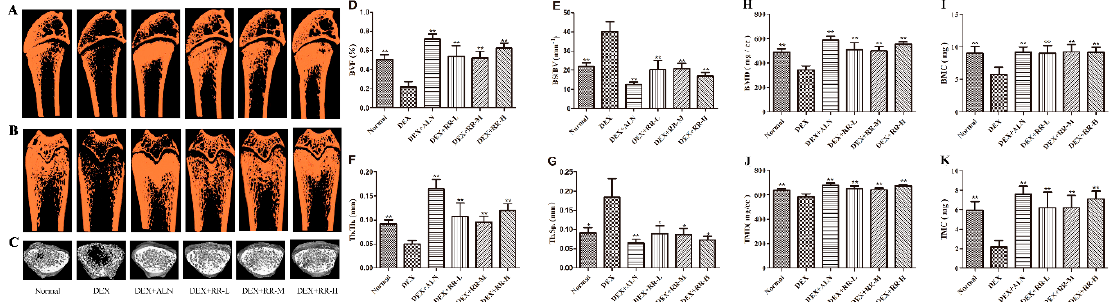
Figure 2. The region of interest (ROI) image and bone parameters analysis in the distal femur in DEX-treated rats. ( A – C ) Micro-CT images of ROI region in longitudinal section, transverse section, and 3-D architecture. ( D – K ) Trabecular bone parameters analysis of ( D ) BVF; ( E ) BS/BV; ( F ) Tb.Th.; ( G ) Tb.Sp.; ( H ) BMD; ( I ) BMC; ( J ) TMD; and ( K ) TMC in the distal femur region in DEX-treated rats. Values were expressed as the mean ± SD; n = 7. * p < 0.05, ** p < 0.01 compared with DEX